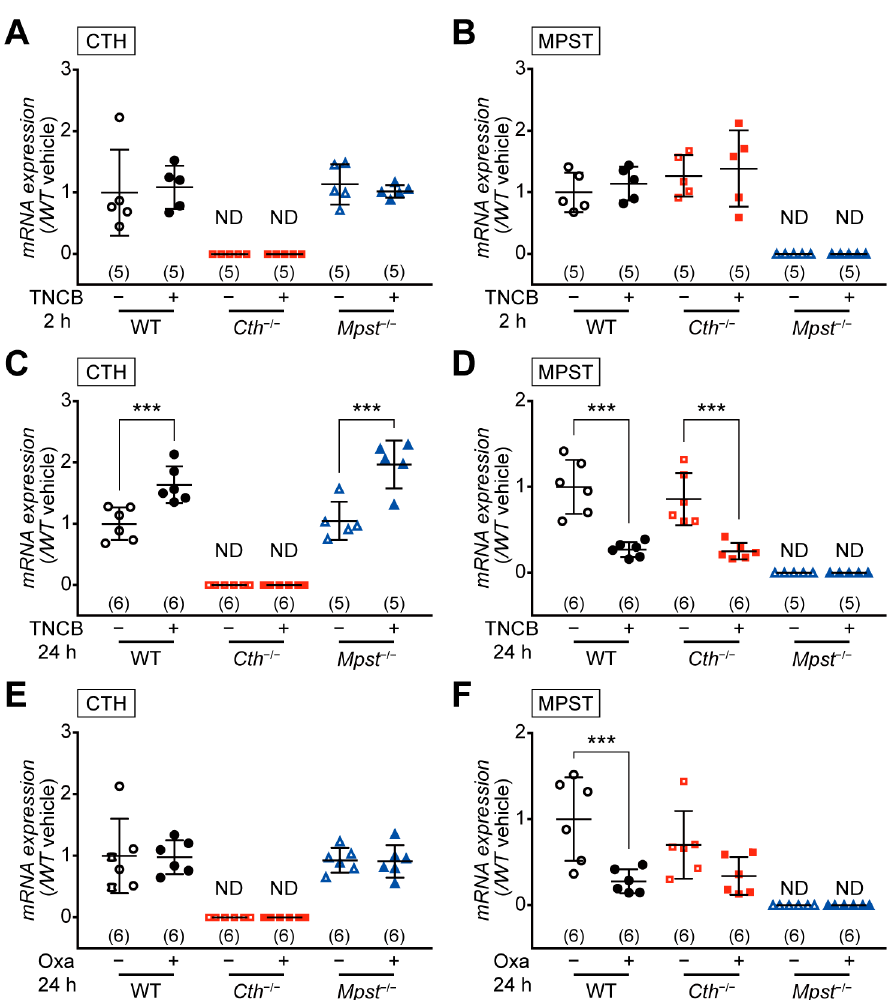
Figure 5. Expression levels of CTH and MPST mRNAs in the ear during hapten-induced contact dermatitis. The total RNA was extracted from each ear at 2 h ( A , B ) or 24 h ( C – F ) after trinitrochlorobenzene (TNCB; A – D ) or oxazolone (Oxa; E , F ) challenge. CTH ( A , C , E ) and MPST ( B , D , F ) mRNA levels were normalized by the housekeeping HPRT1 mRNA levels, and the relative expression versus vehicle-treated wild-type samples were calculated. Data are the mean ± SD (sample numbers) in parentheses. Differences are significant by a one-way ANOVA with Tukey’s multiple comparison test at *** p < 0.001. ND, not detectable.